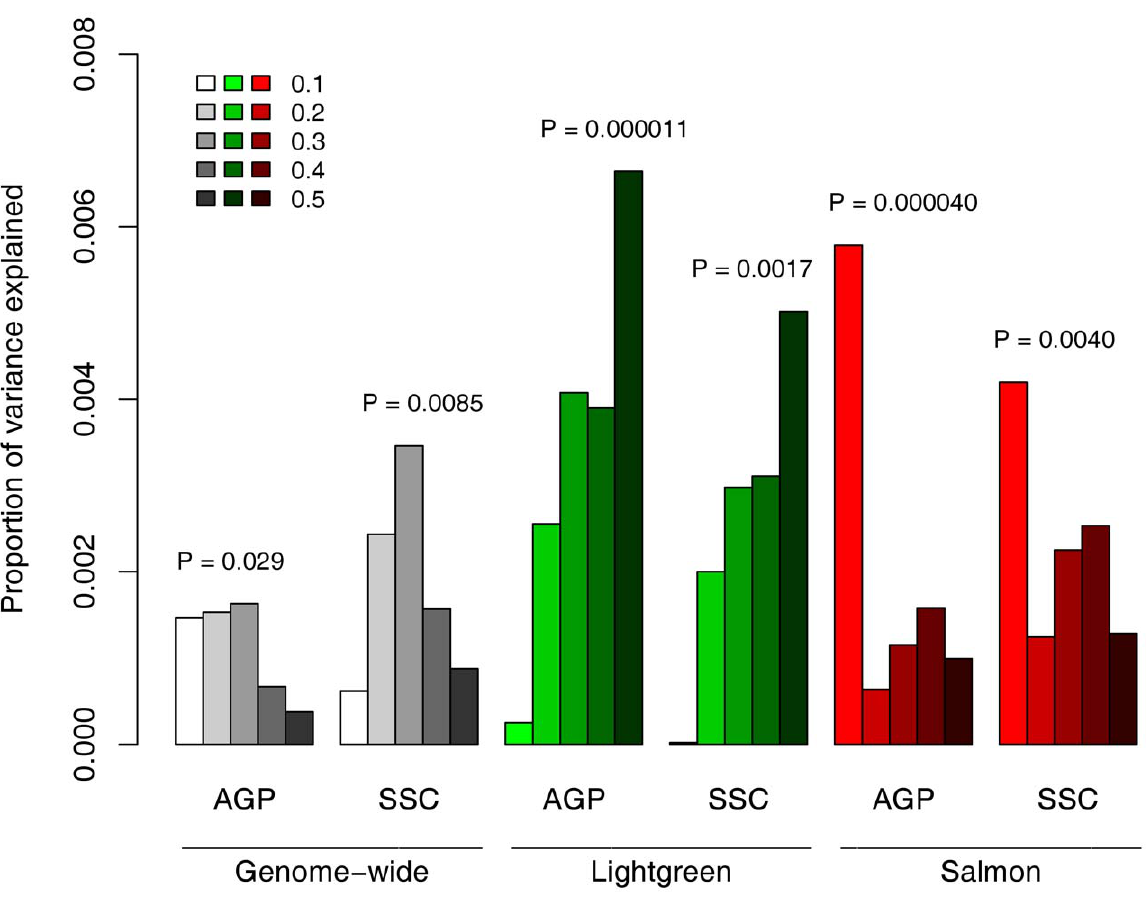
Figure 4. Contribution to ASD risk of common variation in the neuronal sub-networks. Genetic risk scores were calculated for each individual in the AGP and SSC cohorts, based on the genotypes of 79,079 tag SNPs and the association signal in these SNPs in the AGRE cohort. These scores were used to predict ASD status in a logistic regression model. To test the Lightgreen and Salmon modules, the analysis was limited to tag SNPs residing in genes in these modules. In each module and cohort, different series denote different thresholds of P-values, from P T , 0.1 to P T , 0.5.